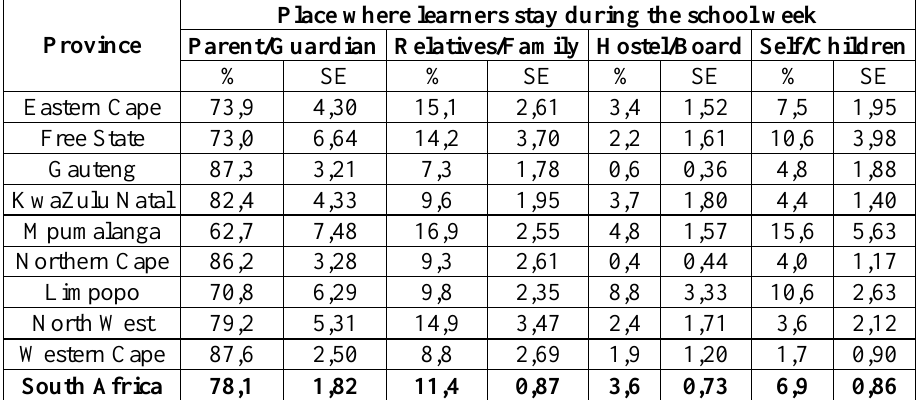
Table 3. School context characteristics: after-school care